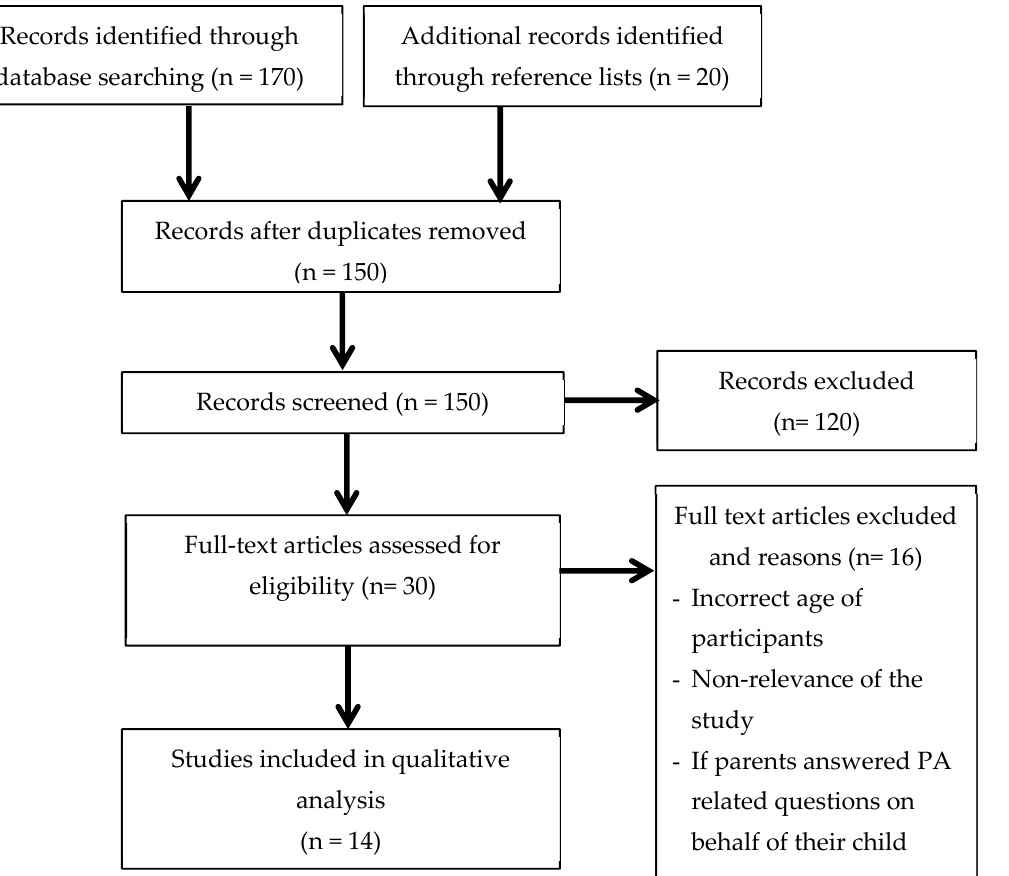
Figure 1. PRISMA flow chart depicting the article filtering process that was undertaken as part of the systematic review.